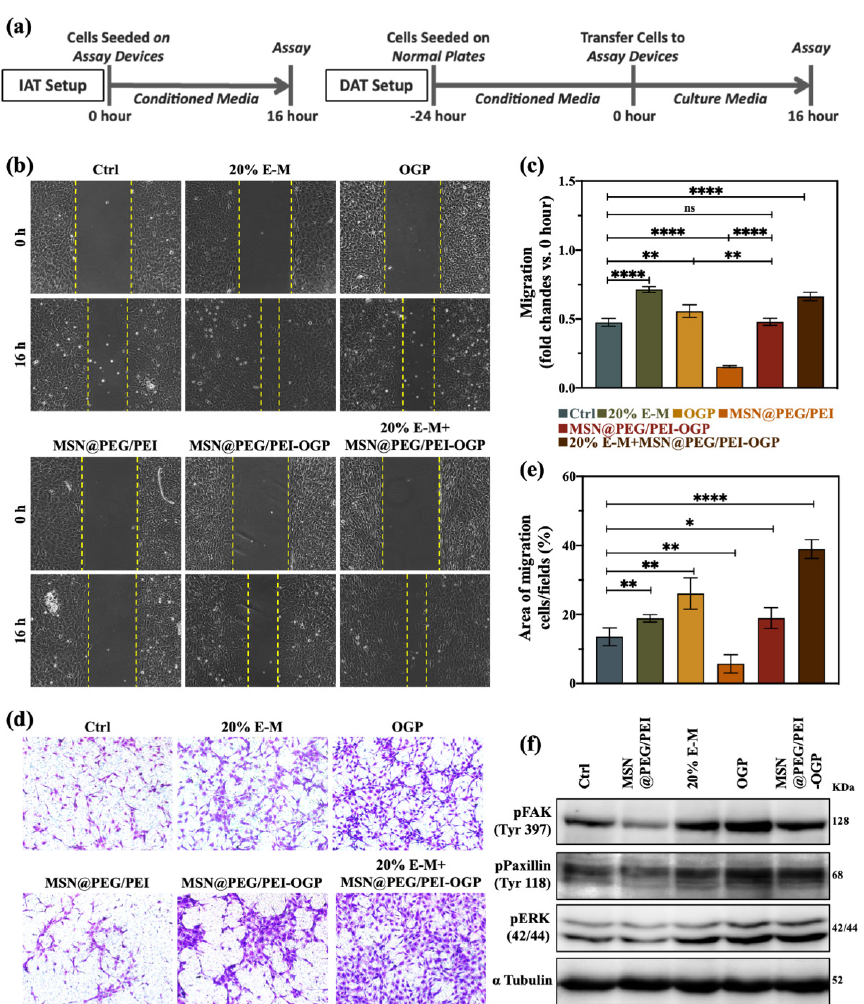
Figure 3. ( a ) Experimental design for cell migration/invasion study. ( b ) Scratch migration (wound healing) assay and ( c ) quantitative evaluation of MC3T3 − E1 cells conducted immediately after treatment (IAT) of the conditioned media. ( d ) Transwell invasion assay and ( e ) quantitative evaluation of MC3T3 − E1 cells conducted delayed after treatment (DAT) after treatment of the conditioned media. ( f ) Western blotting of phosphorylated (p) − focal adhesion kinase (FAK) (Tyr397), p − paxillin (Tyr118), p − extracellular signal − regulated kinase (ERK) (42/44), and α− tubulin expressions in MC3T3 − E1 cells at 24 h post − treatment. The amount of nanoparticles was 100 μ g/mL, and that of OGP was 6.06 μ g/mL. ( n = 3 per group). (Data are the mean ± standard deviation, * p < 0.05, ** p < 0.01, **** p < 0.0001).